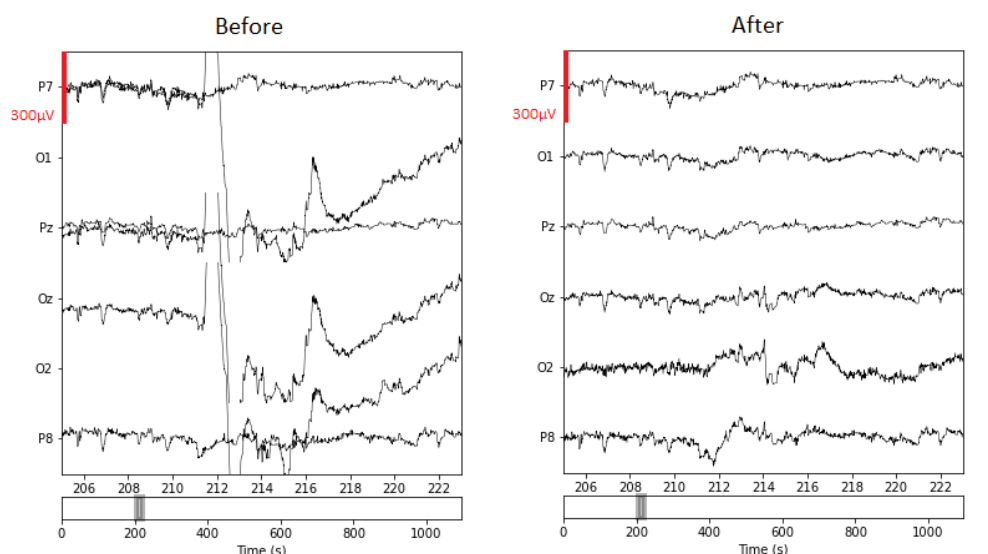
Figure 8. Signals recorded for a sample participant before and after the application of ICA (se- lected 6 channels limited to 18 s). Disruptions in the signal were related to the exceeding of the maximum